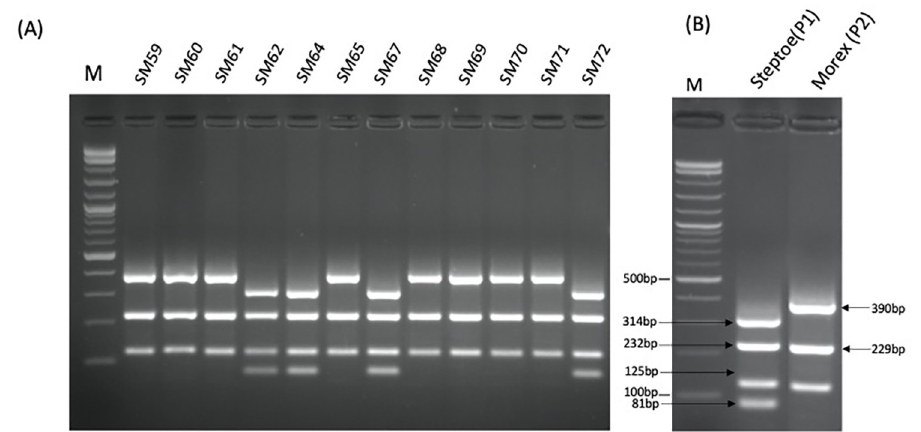
Fig 5. (A) Digestion of 1000 bp downstream 3’ UTR region of HvTLP8 fragment with MwoI in DHs from S x M mapping population. (B) Digestion of mapping population parents. M: 1 kb plus marker.